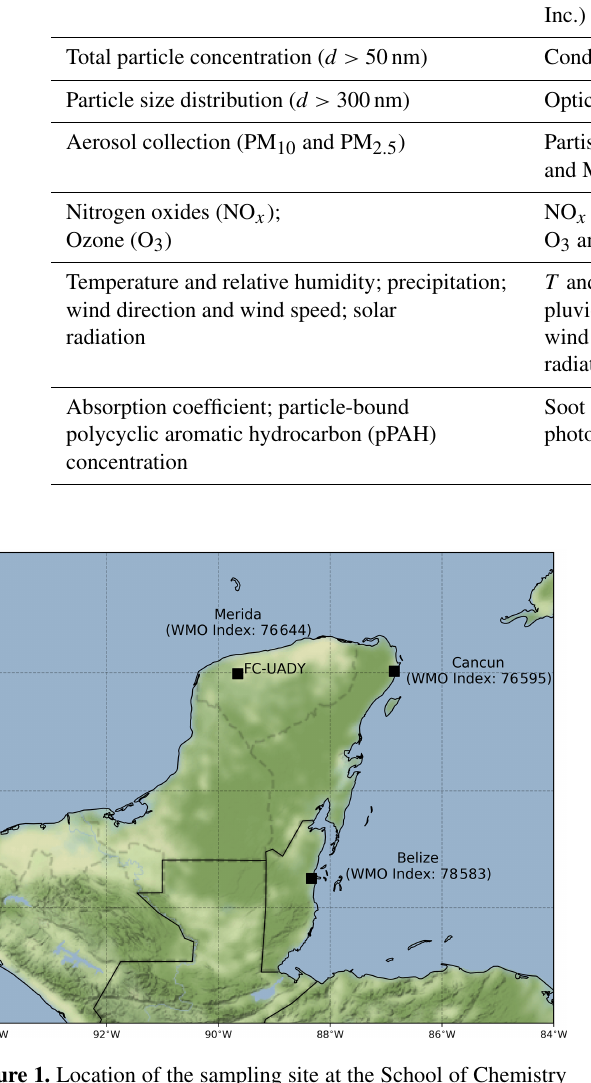
Figure 1. Location of the sampling site at the School of Chemistry of the Autonomous University of Yucatán (FC-UADY) and the three World Meteorological Organization (WMO) radiosonde stations lo- cated on the Yucatán Peninsula: Mérida International Airport, Mex- ico (WMO index: 76644); Cancún, Mexico (WMO index: 76595); and Philip S. W. Goldson International Airport, Belize (WMO in- dex: